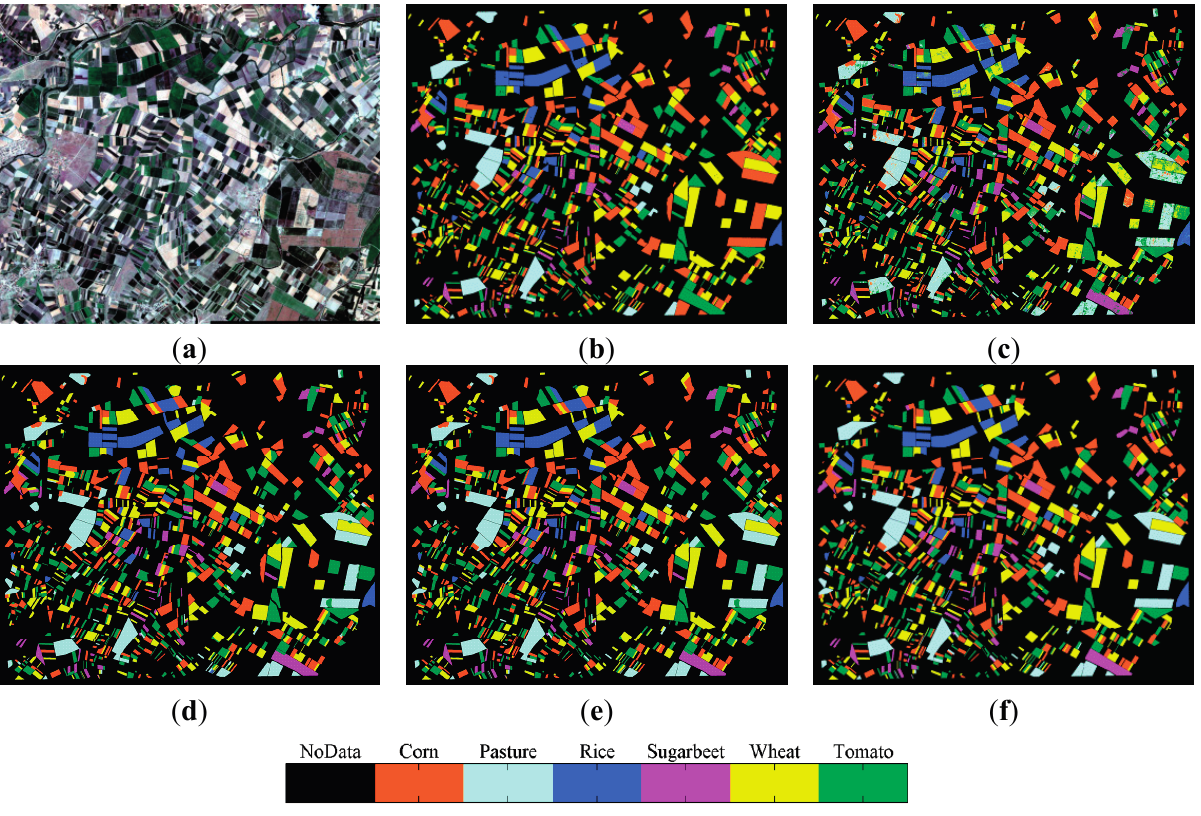
Figure 7. ( a ) Ikonos test image (RGB, 2771 × 2324 pixels, acquired on 15 July 2004), and the ( b ) reference map. Thematic output maps of, ( c ) SVM without smoothing,